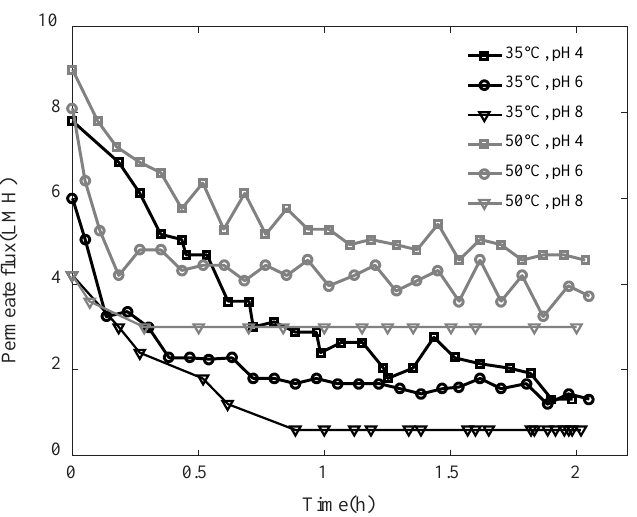
Figure 1. Permeate flux observed when distilling SA-BSA solution at different pH and tempera- tures.